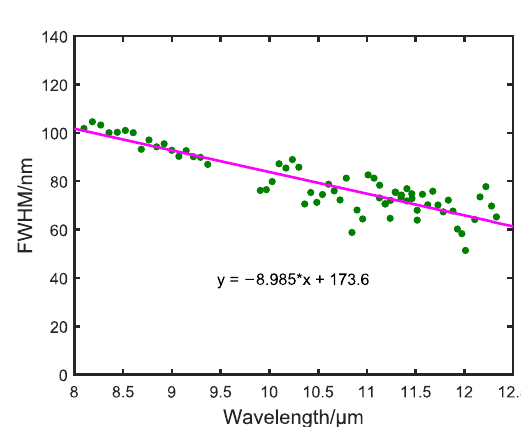
Figure 21. ILS curves of pixels at four specific wavelengths. ( a ) Specific band 1 ; ( b ) Specific band 2 ; ( c ) Specific band 3.